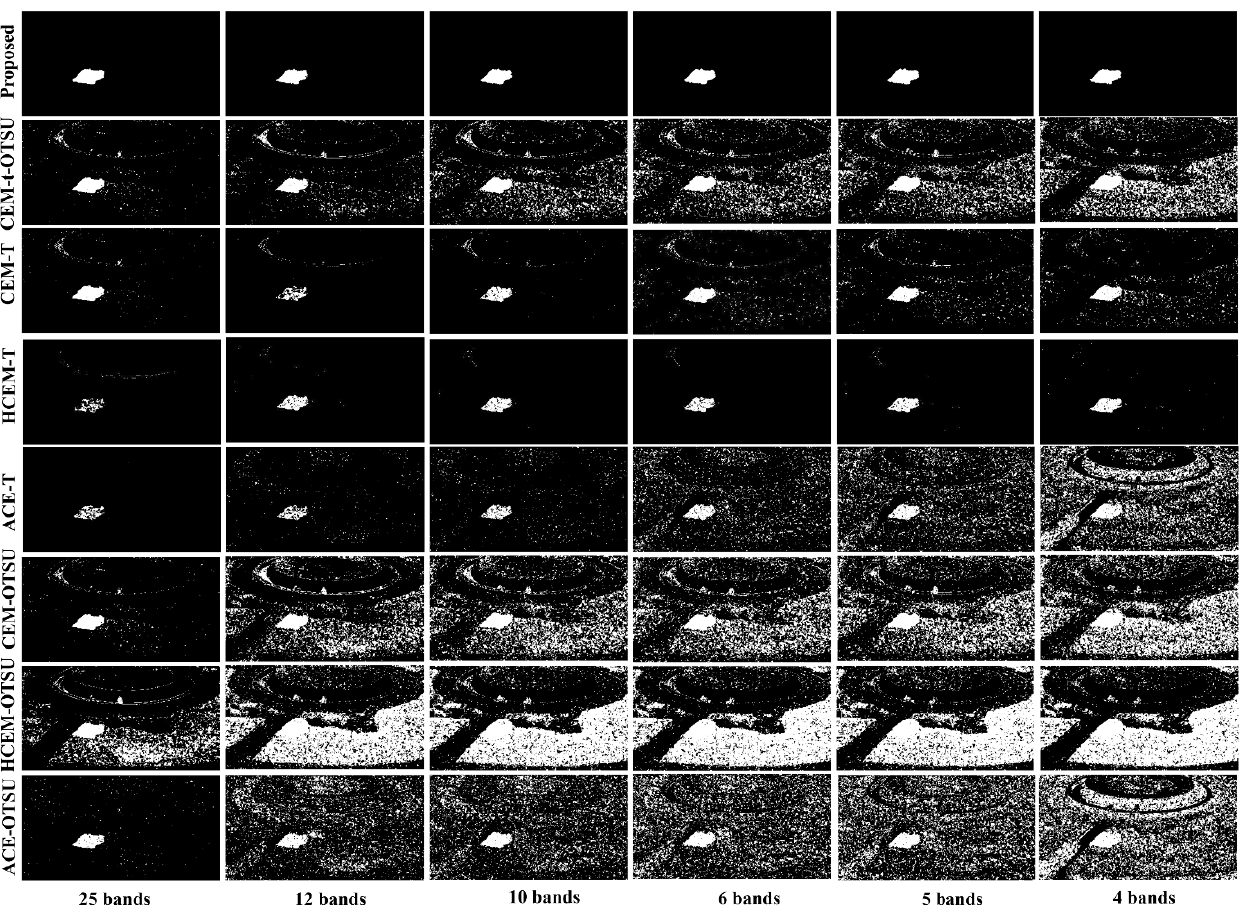
Figure 17. The detection results of the ASRC-net in the BF scene (16 mm focal length) with bands ranging from 4 to 25. All results are normalized to [0,1] for a fair comparison.